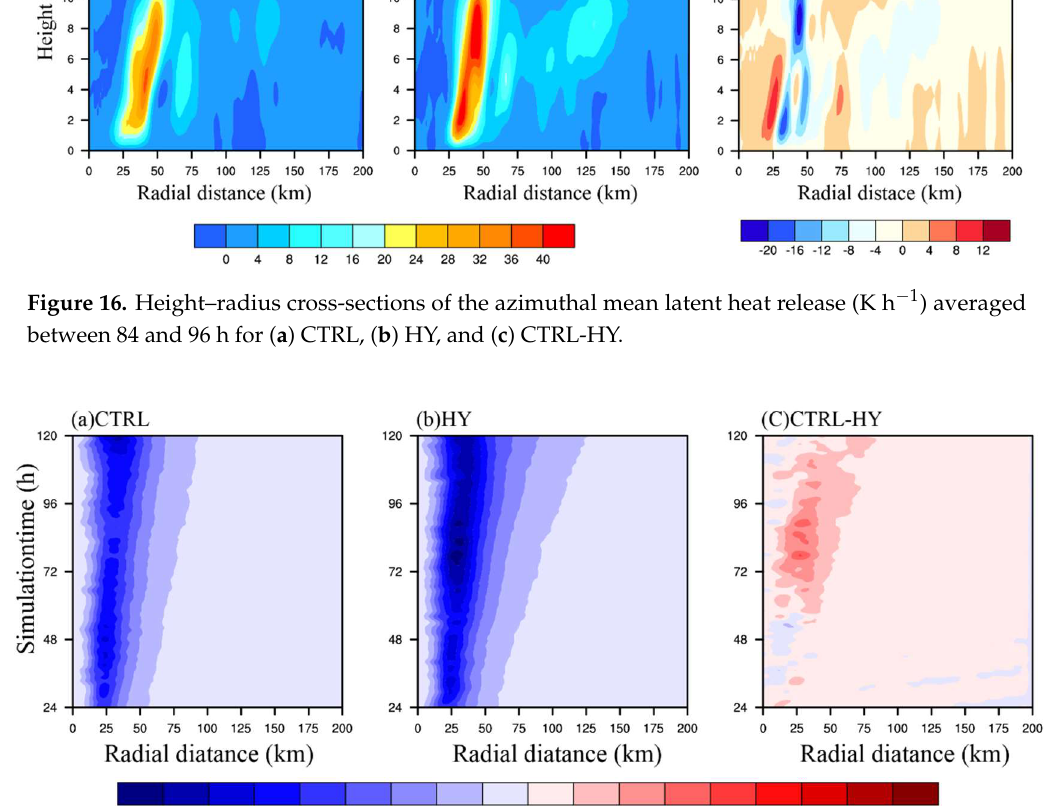
Figure 16. Height–radius cross-sections of the azimuthal mean latent heat release (K h −1 ) averaged between 84 and 96 h for ( a ) CTRL, ( b ) HY, and ( c ) CTRL-HY.